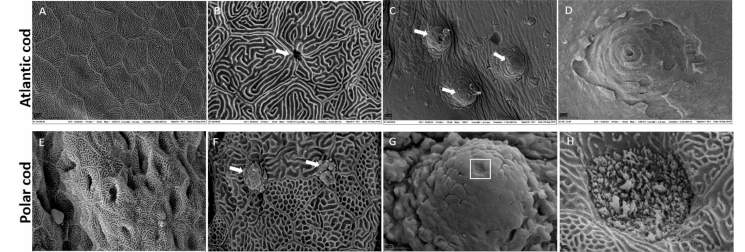
Figure 2. Scanning electron microscopy (SEM) analyses of Atlantic cod and polar cod. ( A ) Skin surface of Atlantic cod with microridges at the surface of the keratocytes, enlarged in ( B ), showing details of the microridges and a mucous cell (arrow); ( C ) sensory cells in the skin, enlarged in ( D ); ( E ) polar cod has more grooves and folded skin structure and more mucous cells, enlarged in ( F ), showing keratocytes with microridges and mucous cells (arrows); ( G ) sensory cell; squared box enlarged in ( H ) showing the microvilli receptors of the sensory